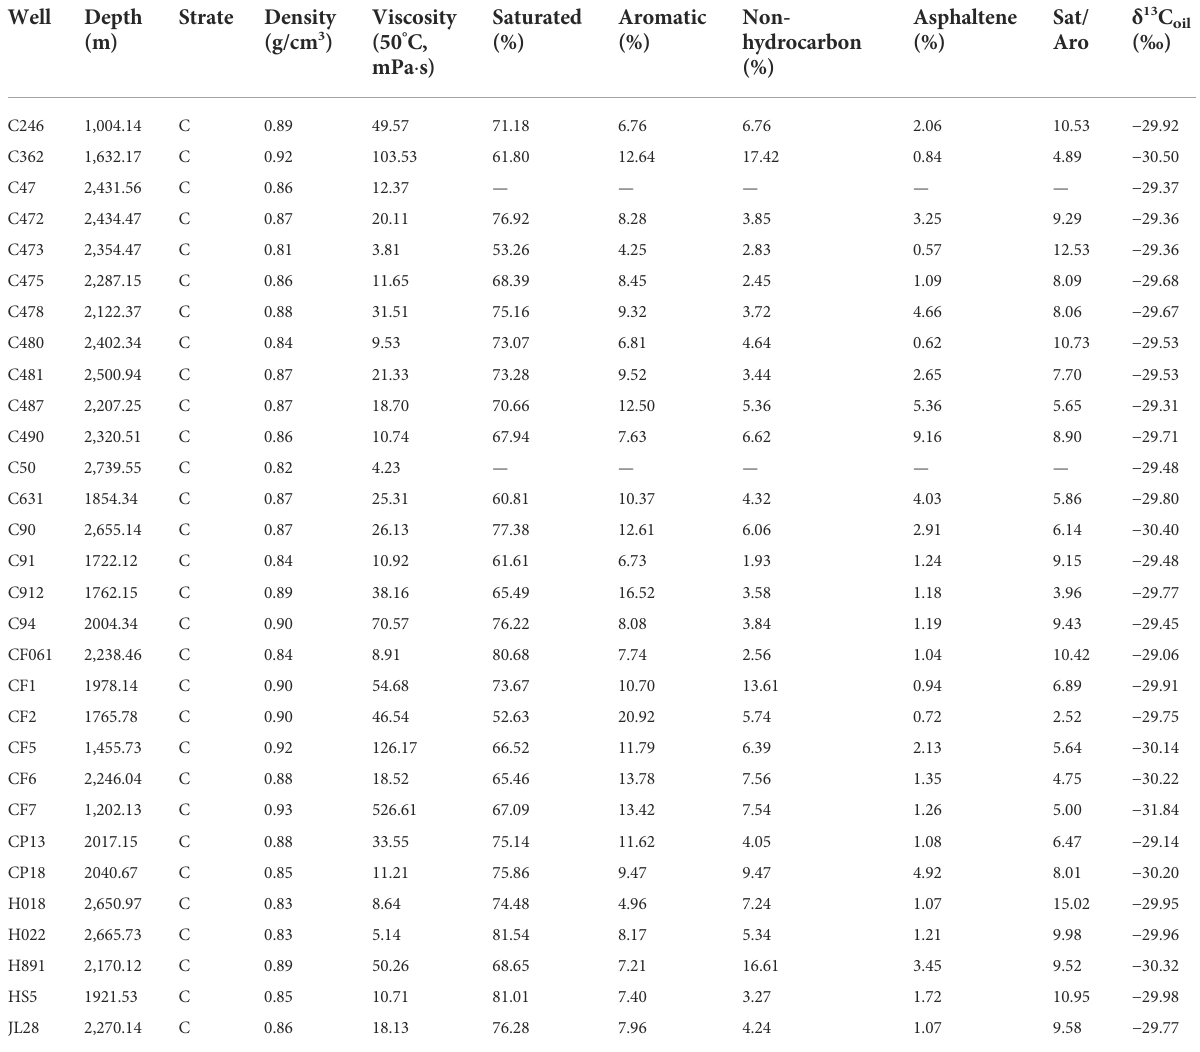
TABLE 2 Bulk physical properties, bulk compositions and stable carbon isotopes from the analyzed Carboniferous crude oil samples in the Hongche fault zone.